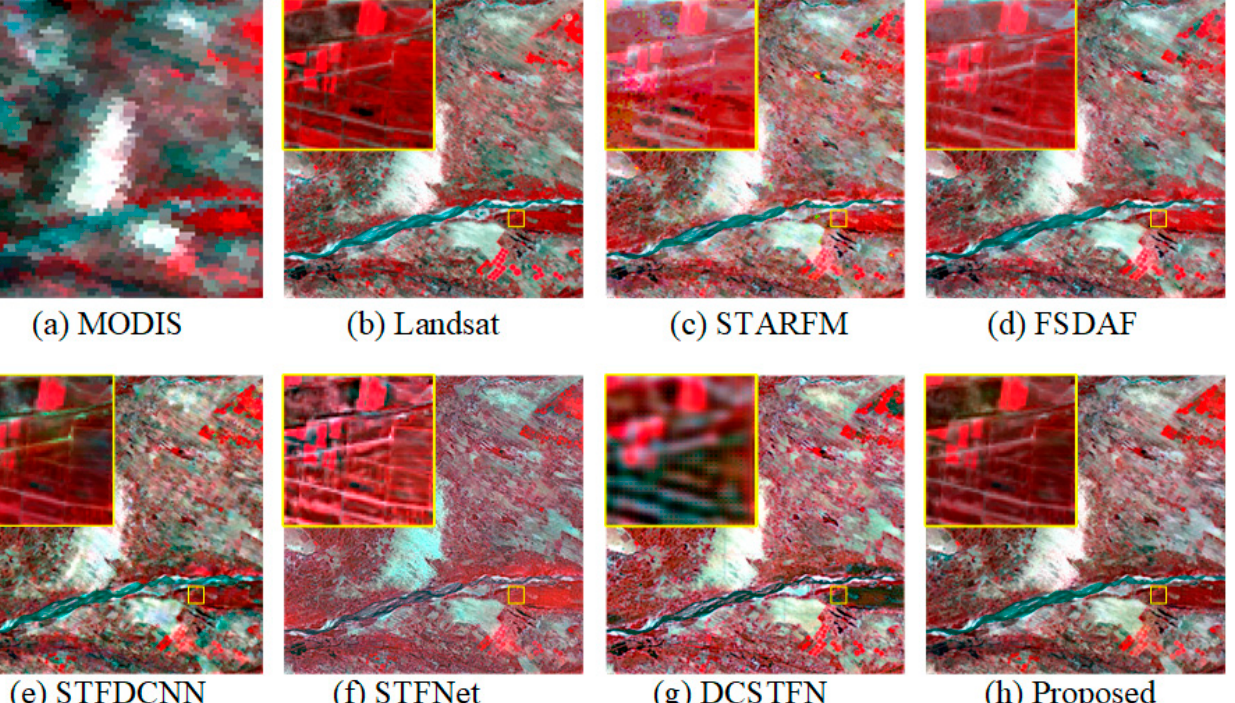
Figure 7. Prediction results of Landsat satellite images (7 July 2015) in the AHB dataset, where ( a ) is the corresponding MODIS image, ( b ) is the real image, ( c – g ) are the prediction results of STARFM, FSDAF, STFDCNN, StfNet, and DCSTFN models, respectively, and ( h ) is the prediction result of our